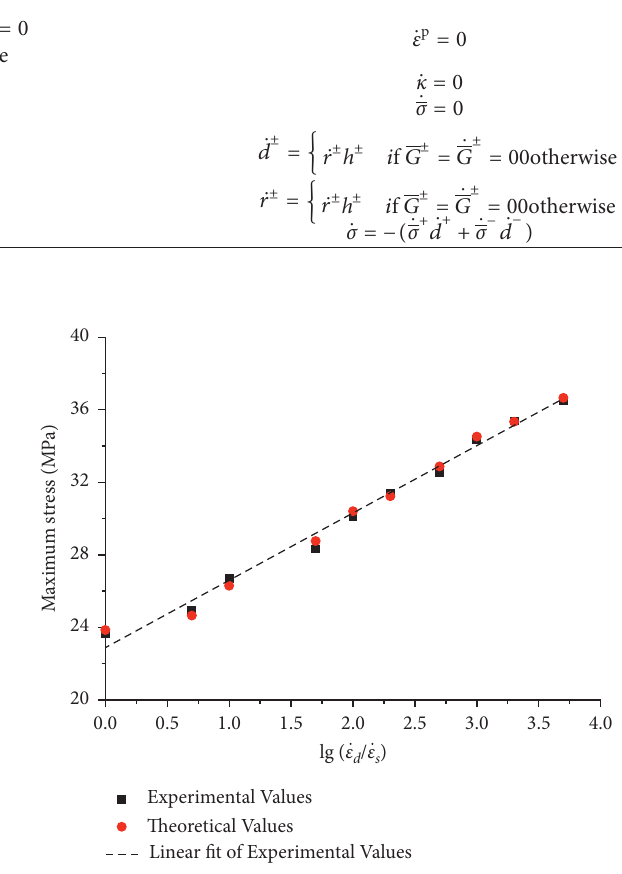
Figure 8: Comparison and analysis of uniaxial compressive strength of light aggregate concrete under different strain